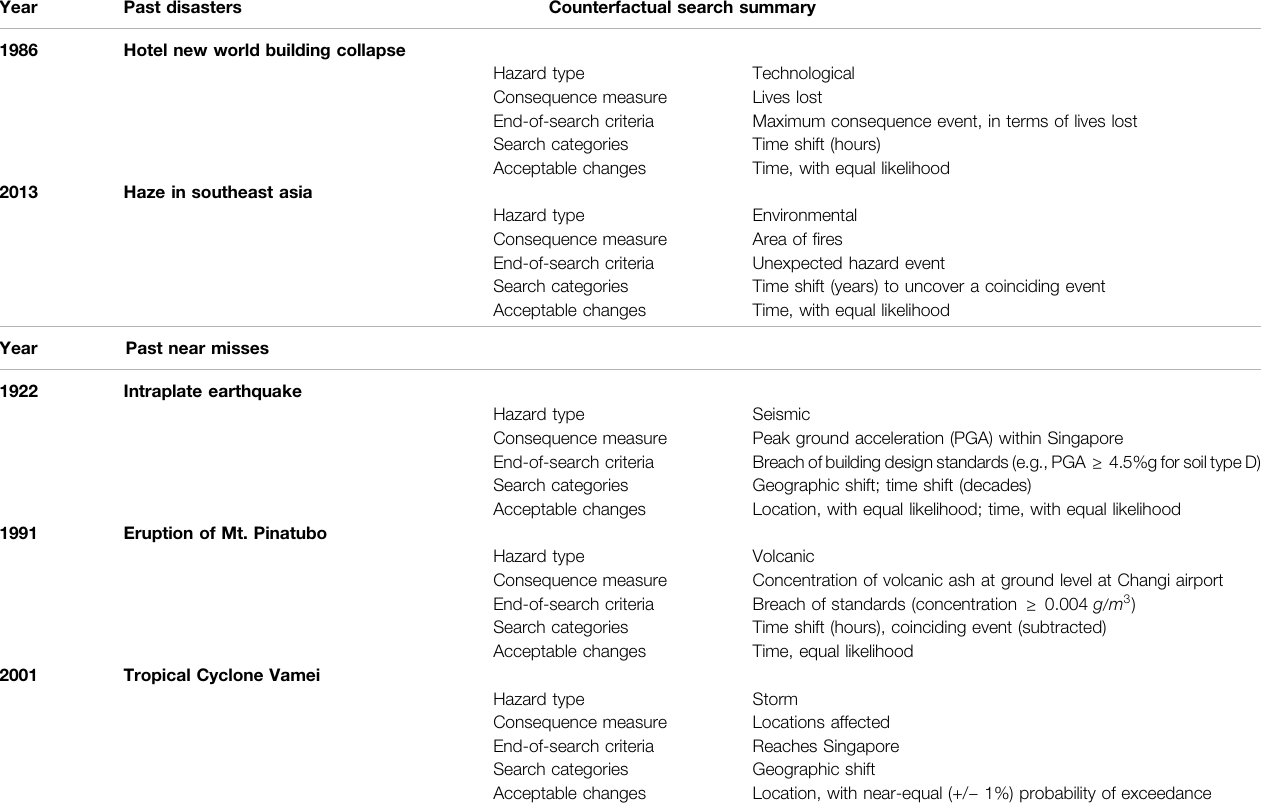
TABLE 1 | Summary of past events and near miss downward counterfactual search case studies in this